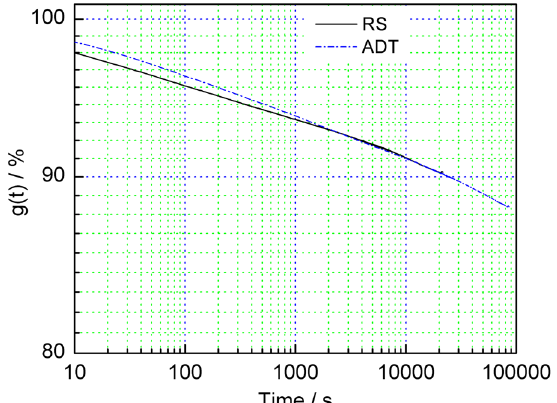
Figure 7: Master curve of stress relaxation for 2 - week exposure samples at a reference solution of RS at 70°C.